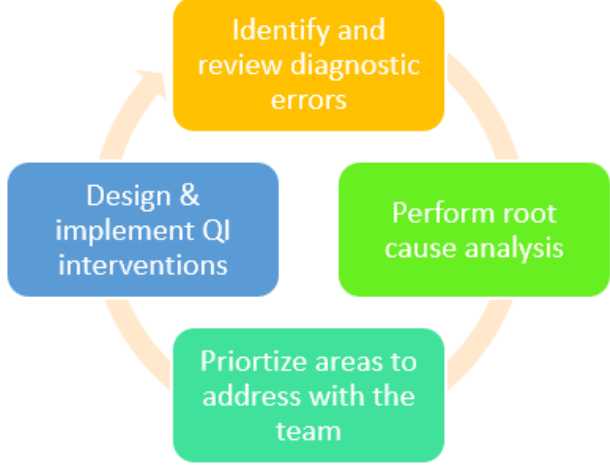
Figure 1. The quality improvement process. QI is both iterative and cyclical.